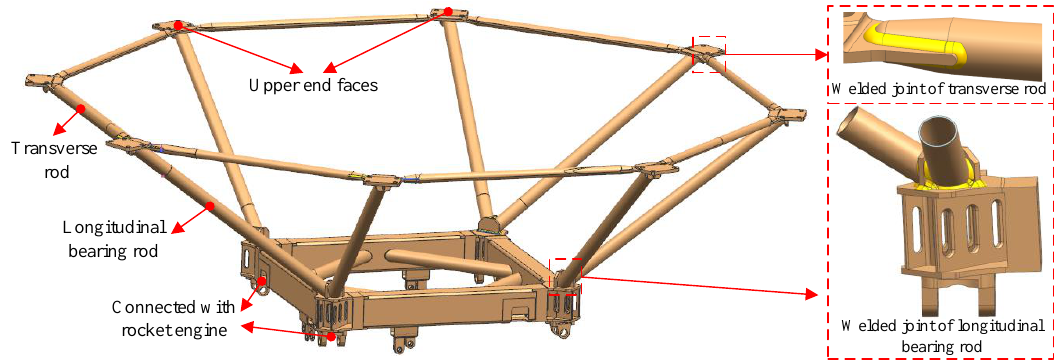
Figure 9. The frame structure and local welded